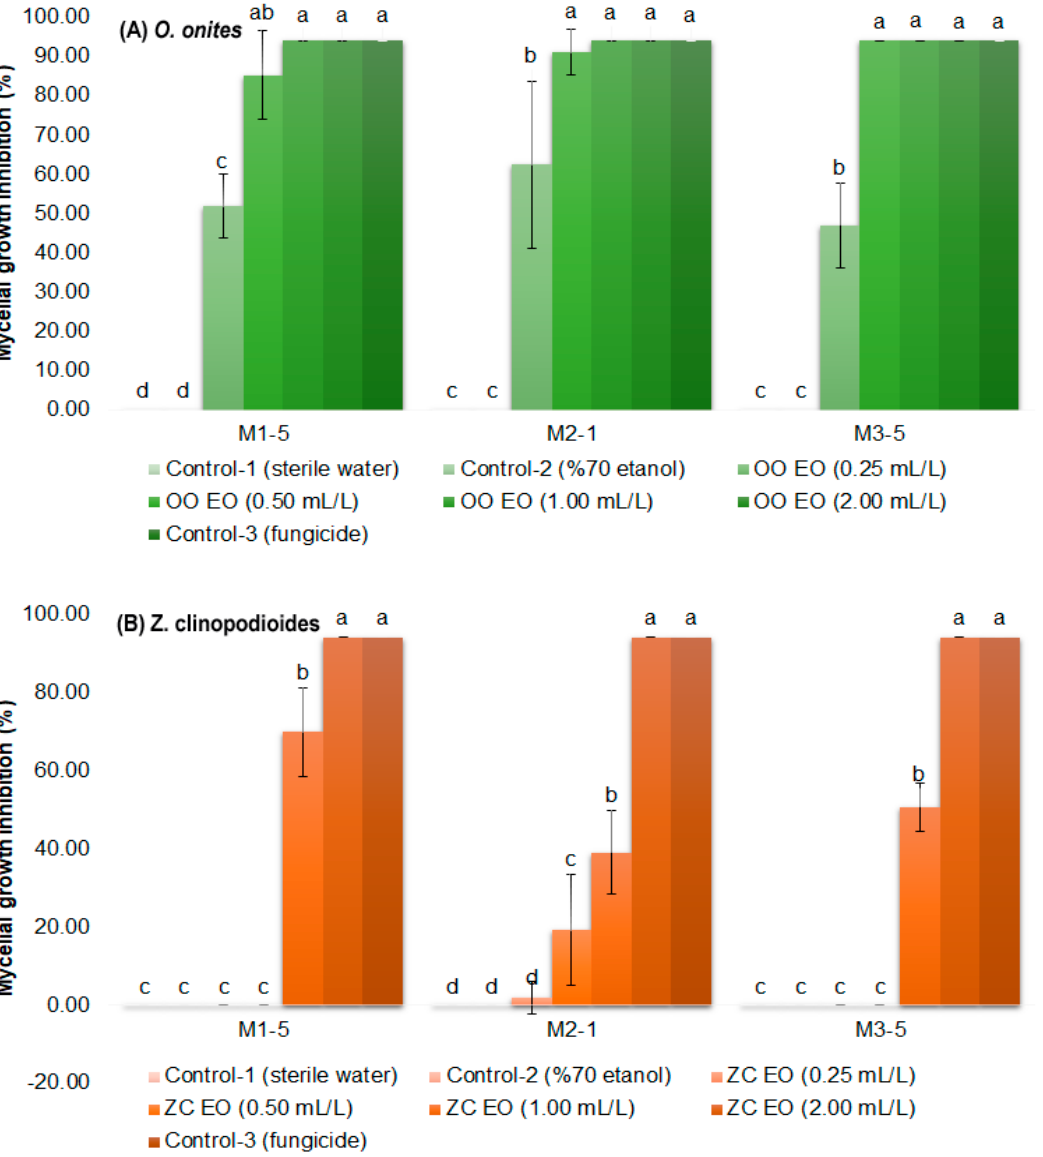
Figure 2. Inhibitory effect of different application doses of ( A ) O. onites and ( B ) Z. clinopodioides essential oils on the mycelial growth of B. cinerea isolates (M1-5, M2-1 and M3-5) on PDA based on contact assays after 7 days of incubation. Different letters next to the values of different isolates on the same rows represents significant difference according to Tukey’s HSD test ( p ≤ 0.05).